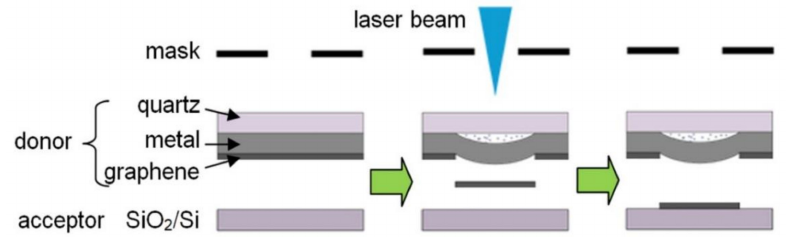
Figure 1. Sketch of the BB-LIFT technique applied to transfer the graphene